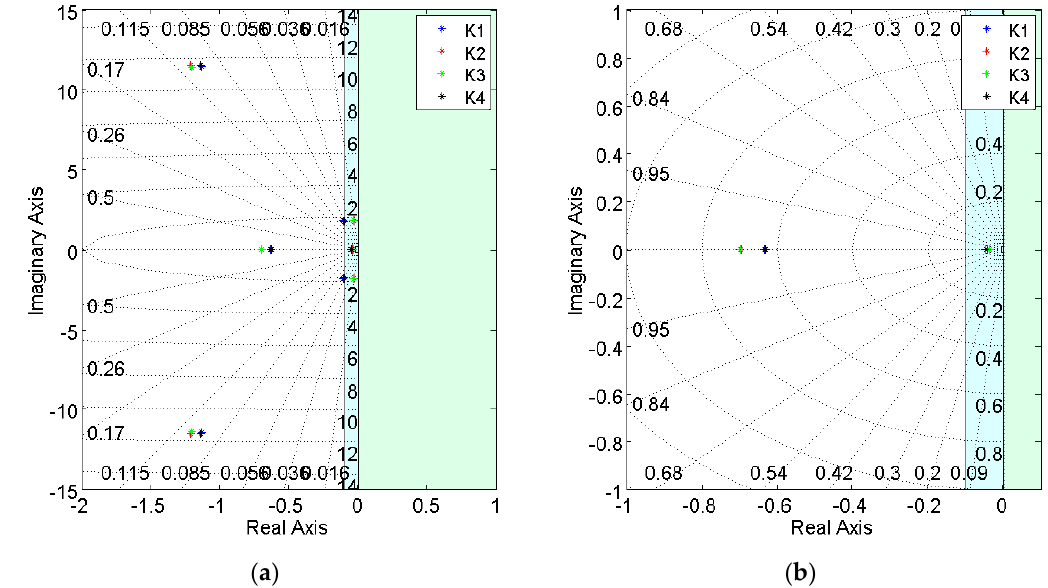
Figure 8. Pole map of the Kharitonov polynomials. 7th order LTI pitch model, ∆ β = 2 ◦ and q 2 ( a ) Original view ( b ) Detailed view.